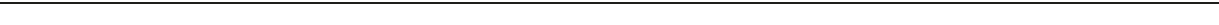
Fig. 5 BC inhibits ZIKV infection of murine male GCs in vitro and in vivo. a Hit compounds that inhibit ZIKV infection in GCs by more than 30%. b Chemical structure of BC. c Inhibition curve of BC. IC 50 = 2 μ M. d Intracellular fl ow cytometry plots of GCs at 72 hpi with ZIKV (MOI = 0.1 PFU per cell) in the presence of 30 μ M BC ( n = 6). e – h qRT-PCR analysis of relative ZIKV cellular ( e ) and negative-strand ( f ) vRNA in GCs, vRNA in supernatant ( g ),